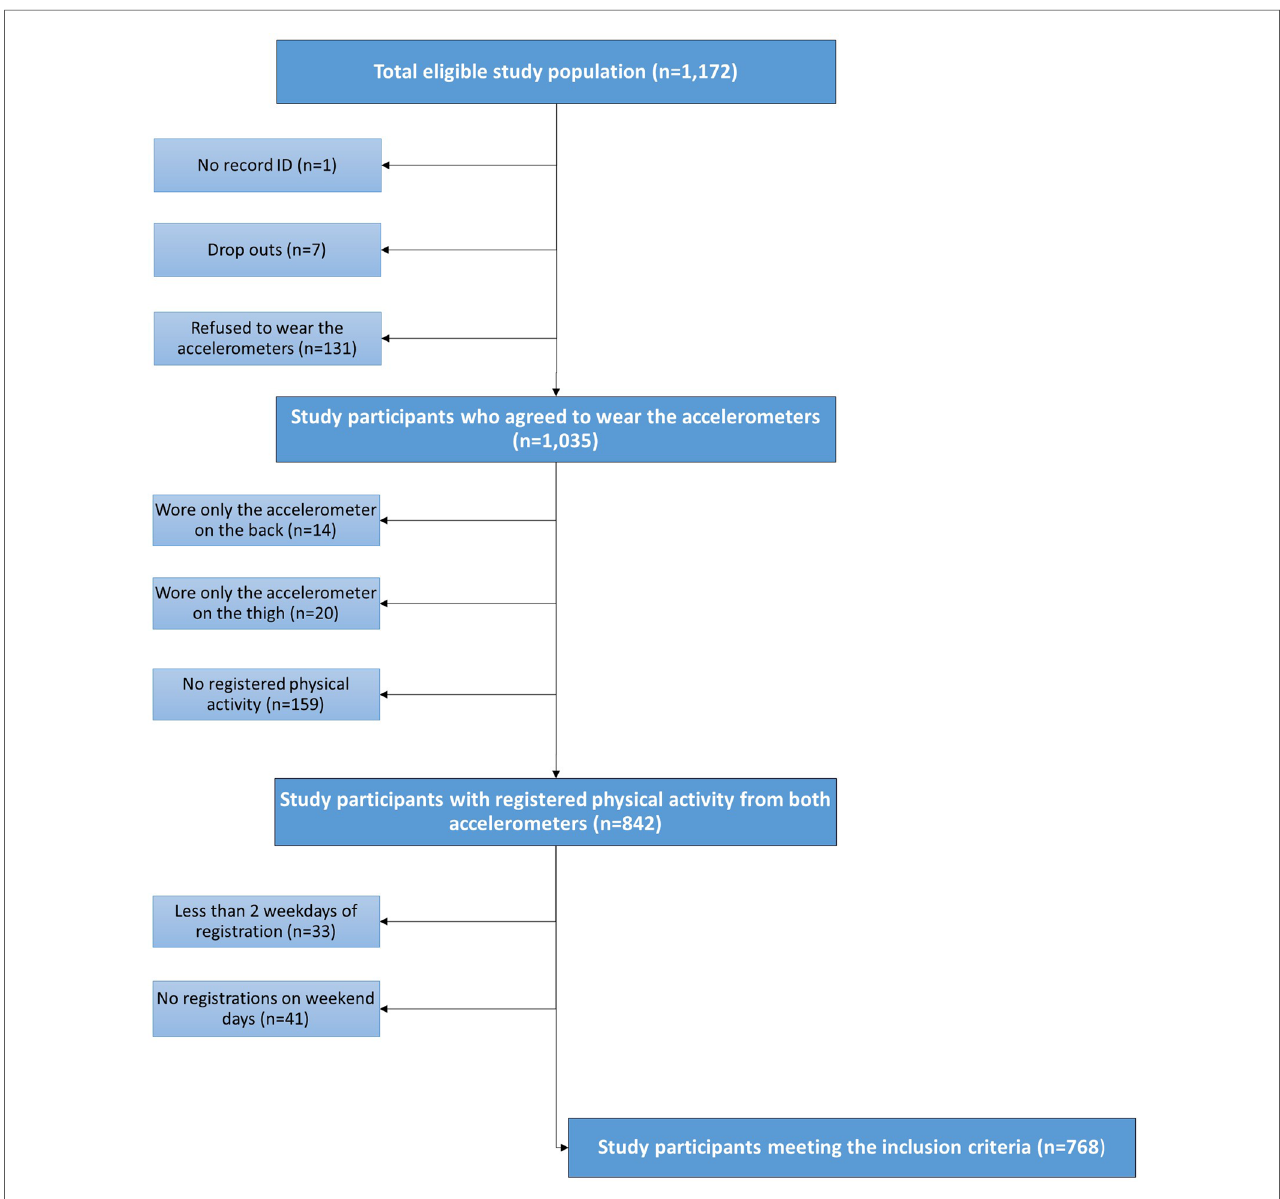
FIGURE 1 Flow diagram of study participants in IDA with registered physical activity and sedentary